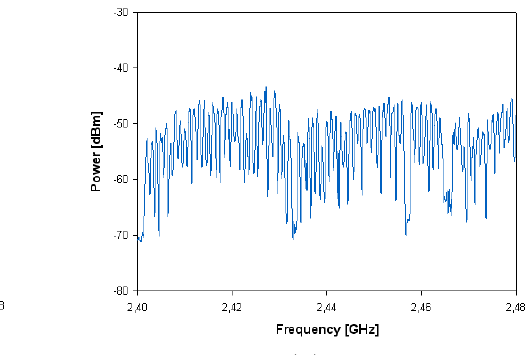
Figure 11. Measured spectrum without transmitting any data with the HOLTIN device ( b ) measured spectrum with the HOLTIN device is transmitting